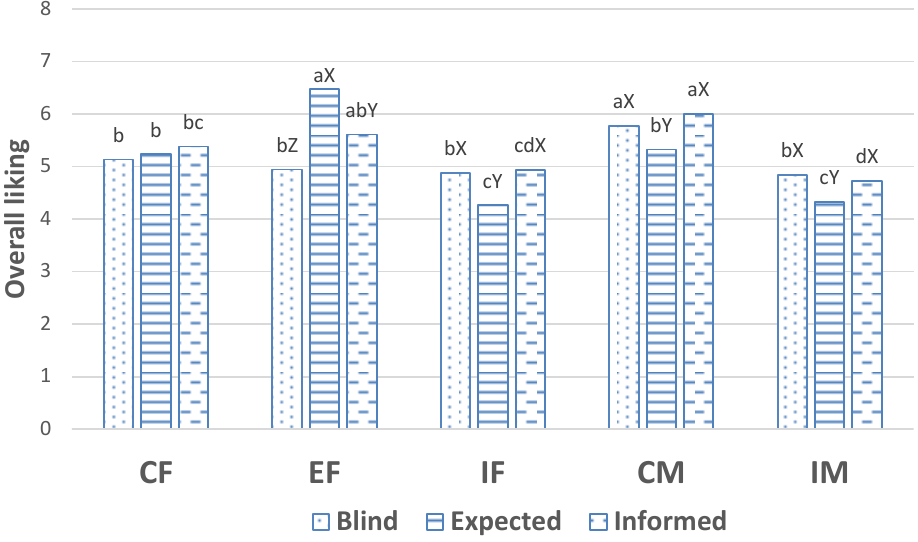
Figure 1. Acceptability of pork from surgically castrated females (CF), entire females (EF), immuno- castrated females (IF), surgically castrated males (CM) and immunocastrated males (IM) obtained from the evaluation meat in blind condition, as expectations and from the evaluation of meat in in- formed conditions according to a scale from 0 (Extremely dislike/I think I would dislike it extremely) to 10 (Extremely like/I think I would like it extremely). Different letters, a,b,c,d indicate significant differences between sex type within condition of information, and different letters X,Y,Z indicate significant differences between conditions of information and within sex